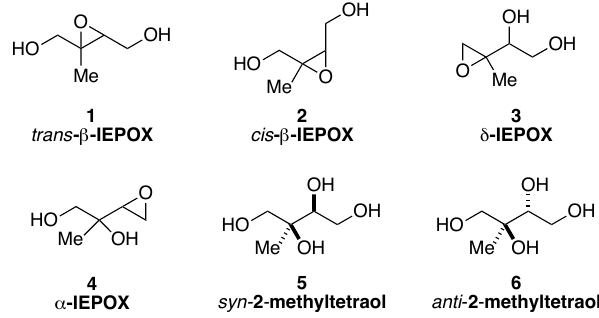
Fig. 1. Chemical structures of the isoprene-derived oxidation prod- ucts synthesized and analyzed in this